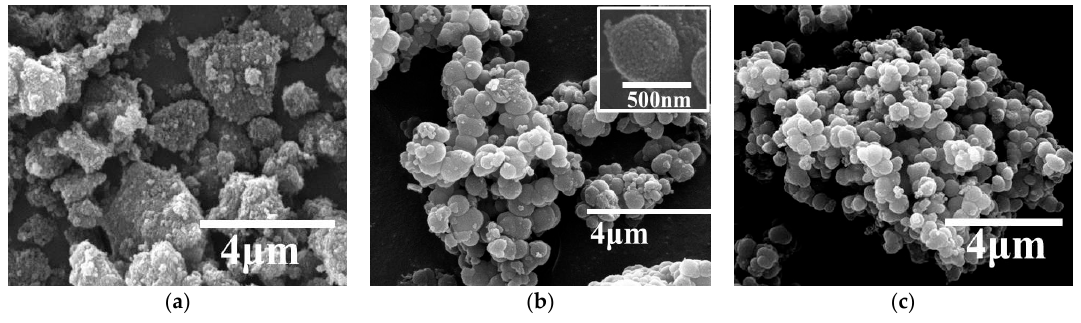
Figure 3. Surface images of ( a ) AG, ( b ) RCP-AG(15), and ( c ) RCP-AG(18).